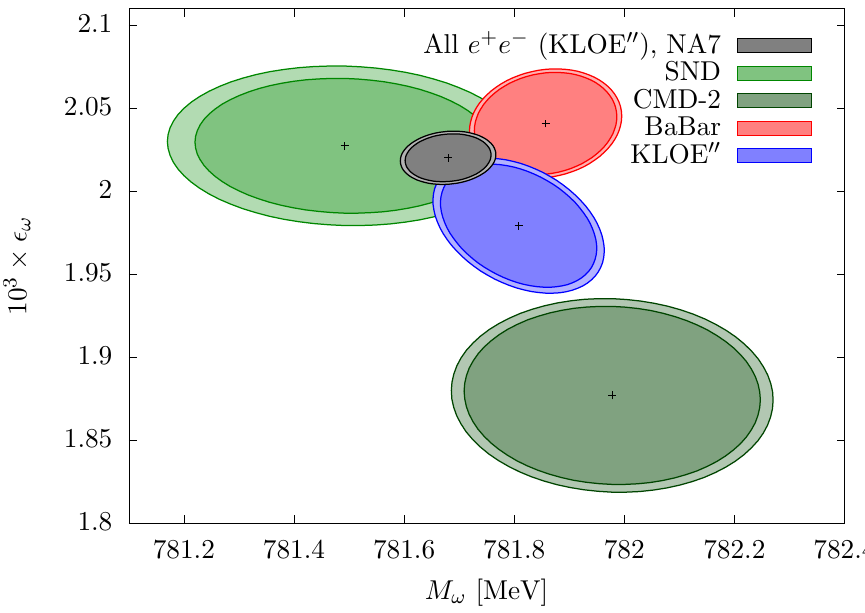
Figure 13. Error ellipses for the parameters (cid:15) ! and M ! resulting from (cid:12)ts to single experiments and the (cid:12)t to the combination of all experiments. The smaller ellipses are standard error ellipses that correspond to (cid:1) (cid:31) 2 = 1, the larger ellipses are in(cid:13)ated by the scale factor (4.13).